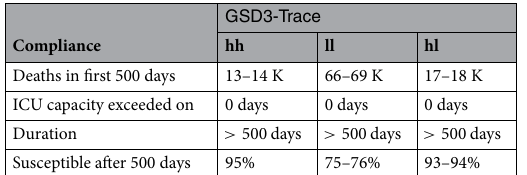
Table 10. Results for the group-specific social distancing scenario GSD3 with tracing.